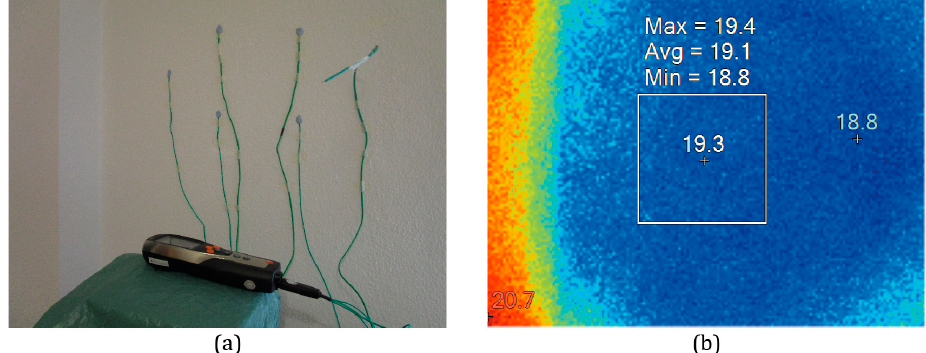
Figure 2. ( a ) Installation of the equipment and ( b ) internal qualitative assessment by means of infrared thermography.